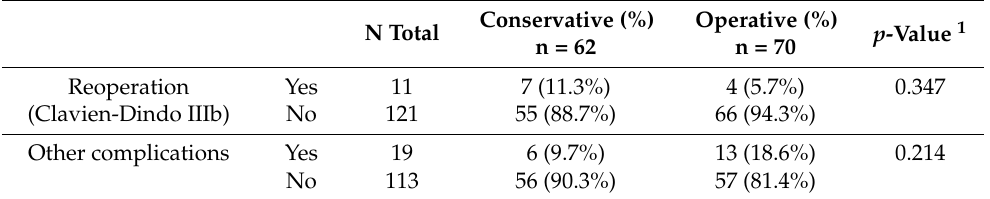
Table 4. Reoperations and complications by type of primary operations.